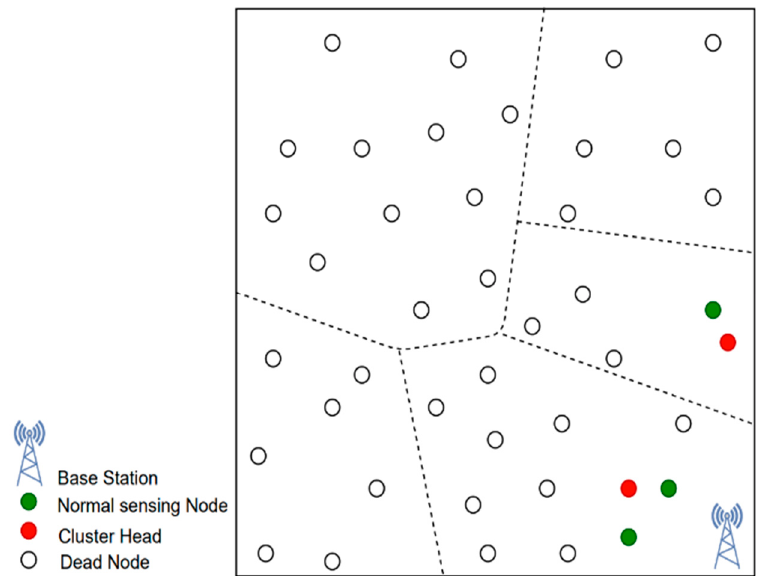
Figure 3. Scenario where most of the area is unmonitored in a live